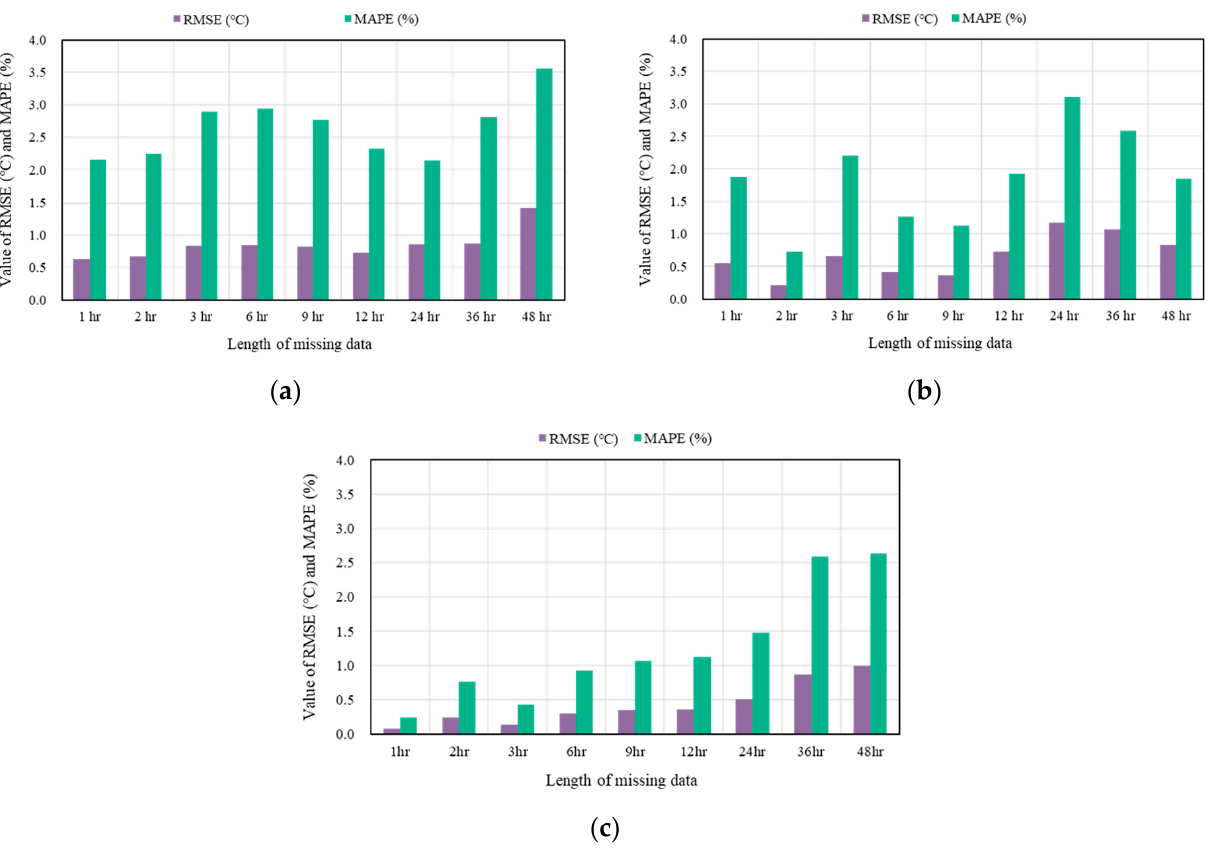
Figure 12. A comparative analysis of the model accuracies according to the length of the missing data. ( a ) Sequential model. ( b ) Reverse model. ( c ) Bidirectional model. data. ( a ) Sequential model. ( b ) Reverse model. ( c ) Bidirectional